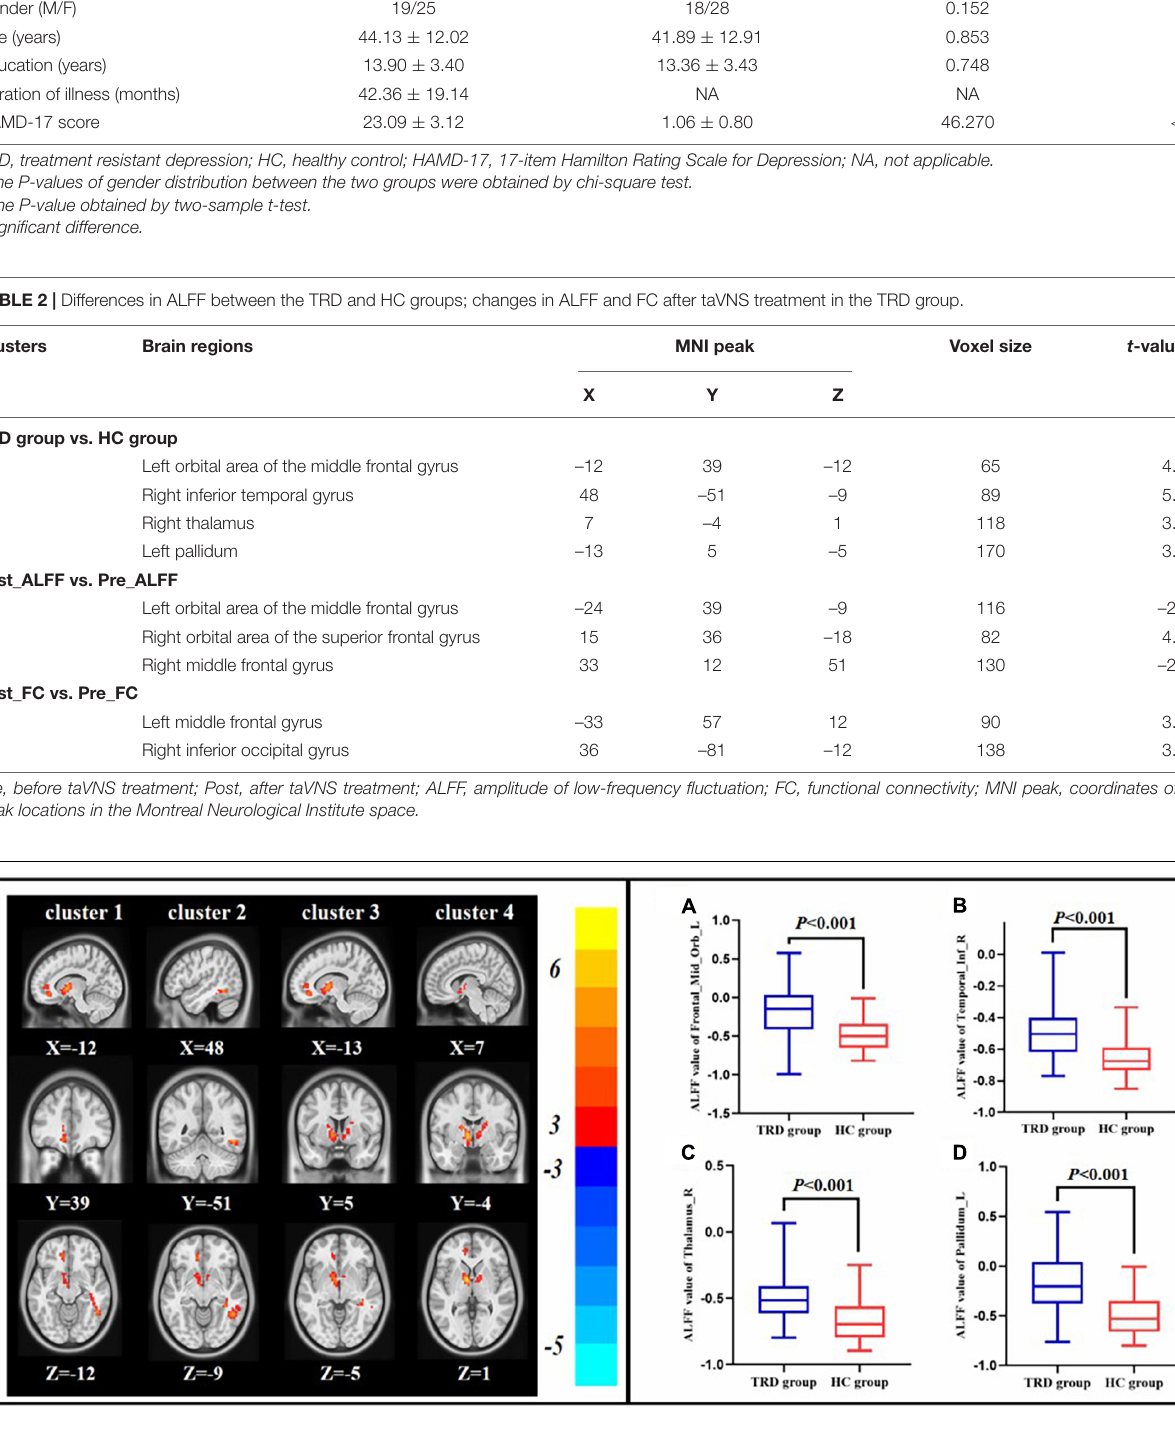
FIGURE 3 | Difference in ALFF between the pre-treatment TRD and HC groups. ALFF value of left orbital area of the middle frontal gyrus (A) , right inferior temporal gyrus (B) , right thalamus (C) , and right angular (D) .